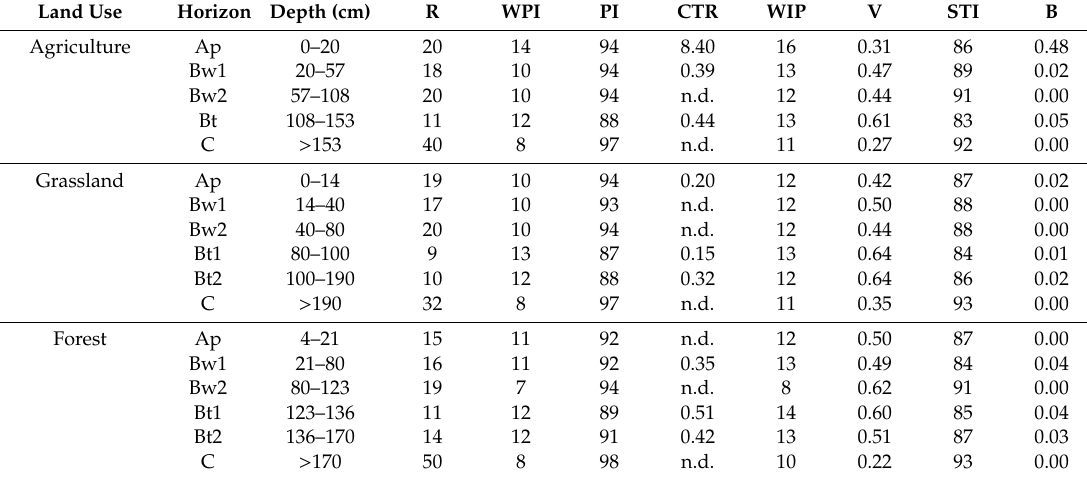
Table 5. Weathering indices (calculated using molecular proportions of element oxides using the equations listed in Table 2) for the bulk soil in three sandy Alfisols under di ff erent land use. The indices were calculated using data collected from the pXRF. Note, Na and K were not included in the